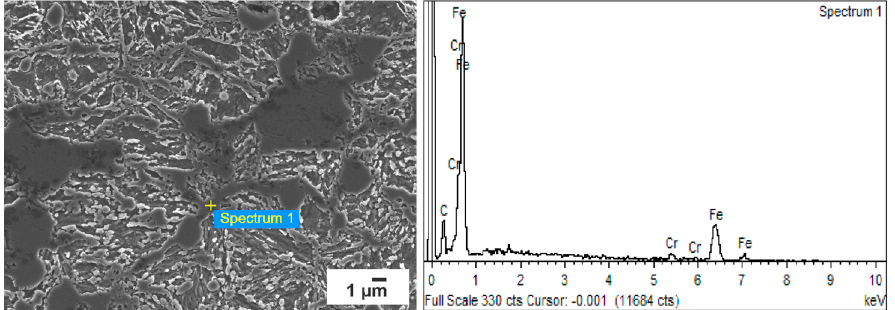
Figure 6. EDX analysis of an elongated shape in the nitrided layer after “B” treatment.